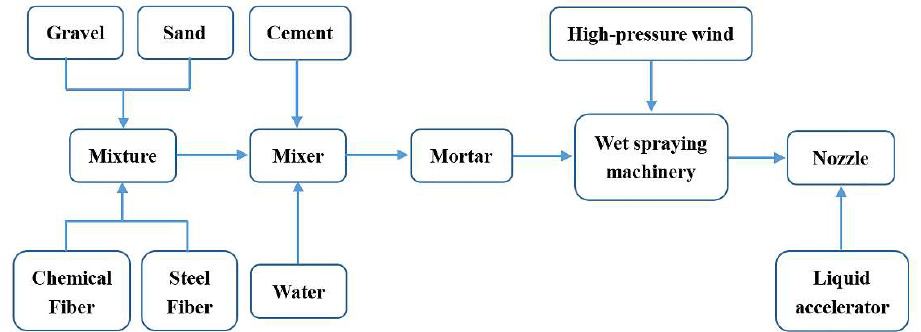
Figure 22. Wet shotcreting process of chemical fiber reinforced concrete.